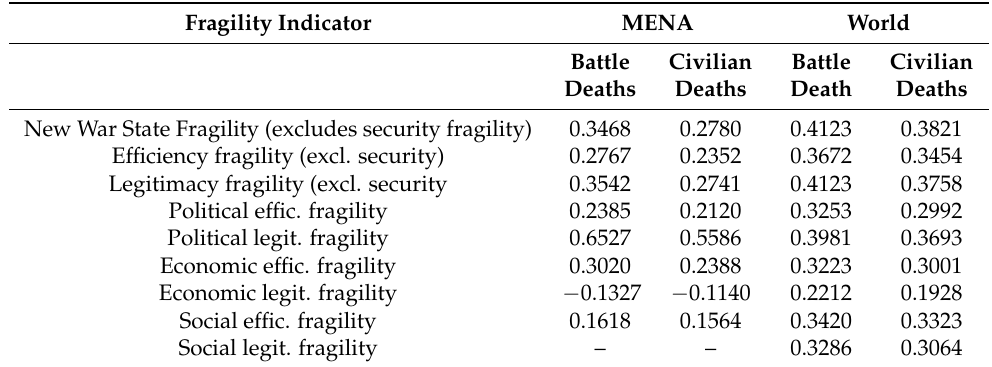
Battle Civilian Battle Civilian Deaths Deaths Death Deaths